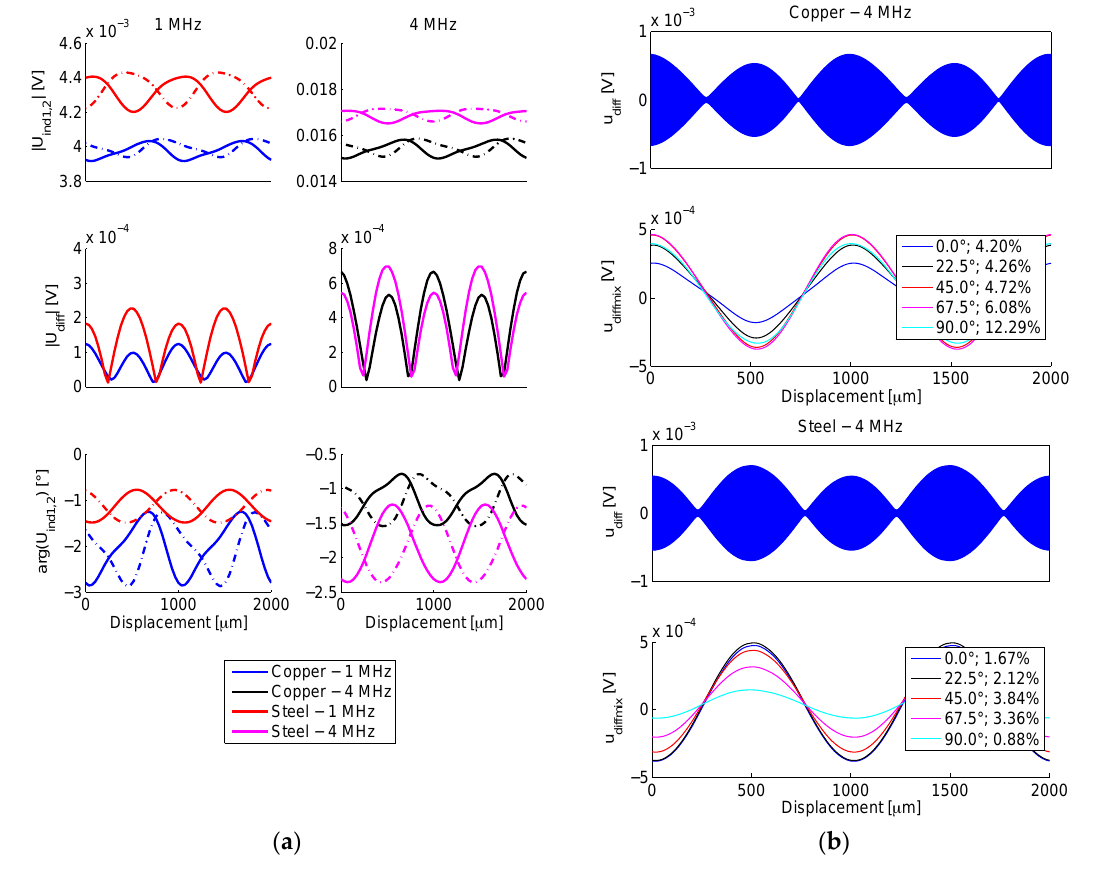
Figure 8. ( a ) Simulated displacement dependence of the amplitude and phase of the secondary induced signals U ind 1 , U ind 2 (shown in dotted lines), and the differential signal U diff ; ( b ) The time-domain differential signal u diff for the steel and copper scale at 4 MHz is shown. A percent THD value of thesynchronously demodulated signals u diffmix at their corresponding phases of the mixing signal ϕ mix is also given in the legend.